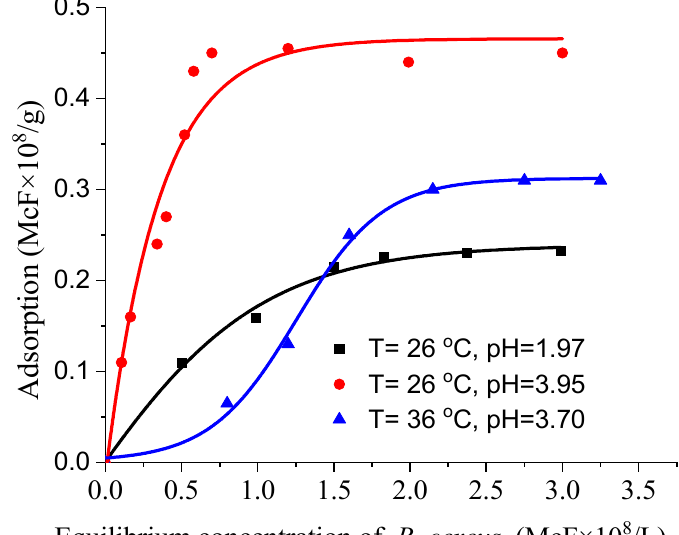
Figure 3. Adsorption isotherm of B. subtilis bacterium on AC-A enterosorbent.